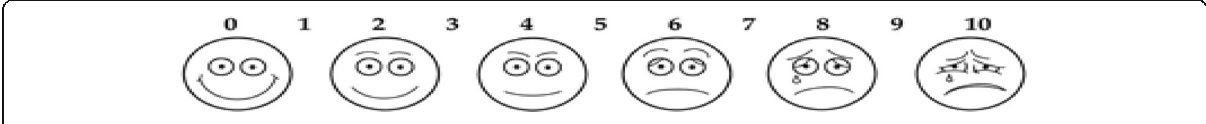
Fig. 13 Visual analog scale for cosmetic appearance of the surgical wound